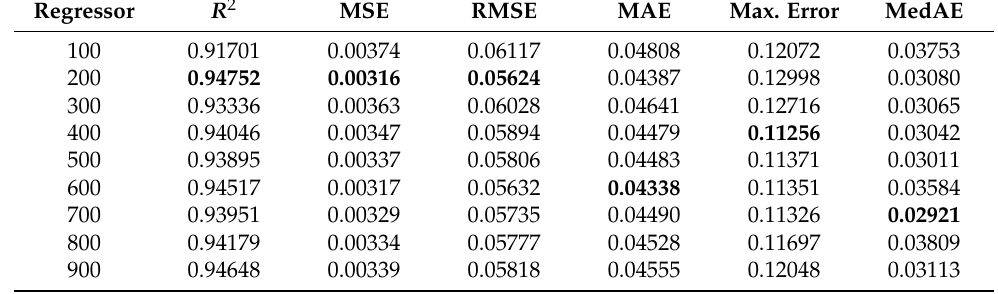
Table 3. Effect of the number of regressors on predictive performance of the MRR random forest model.